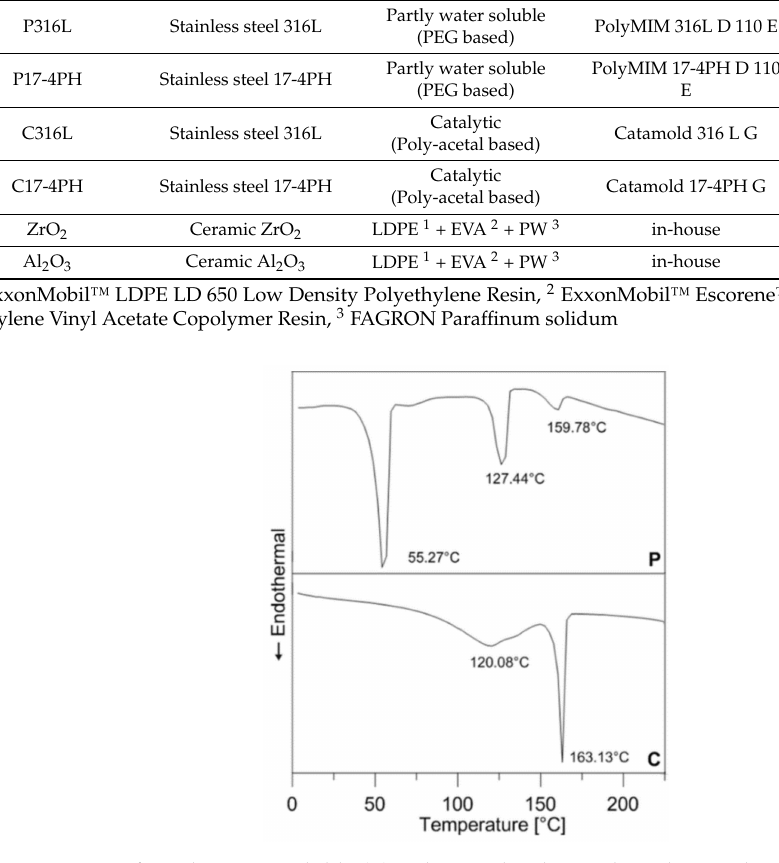
Figure 1. DSC of partly water soluble (P) PolyMIM binder, and catalytic polyacetal (C) Catamold (BASF) binder systems (10 ◦ C/min, second heating